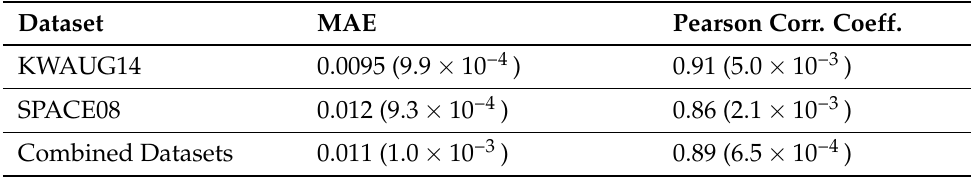
Table 3. Convolutional neural network regression